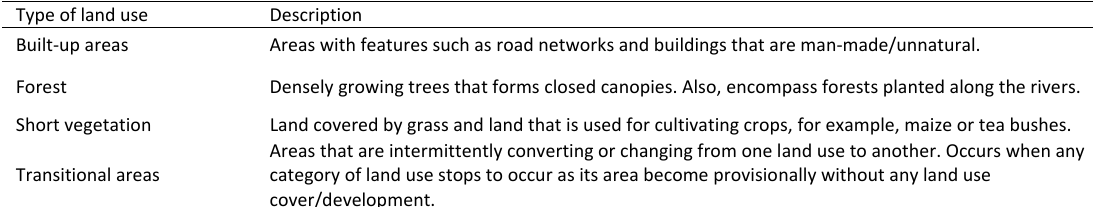
Table 1: Land use classification for Nyamage